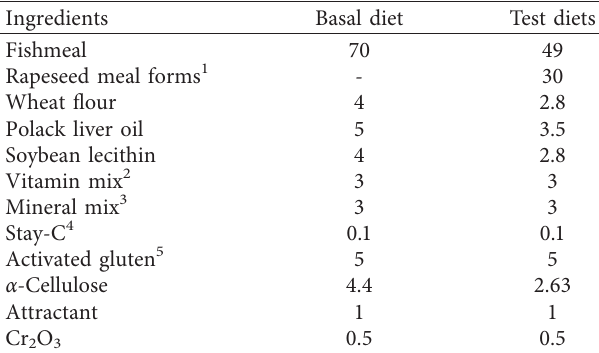
Table 1: Ingredients (g/kg) of basal and test diets.